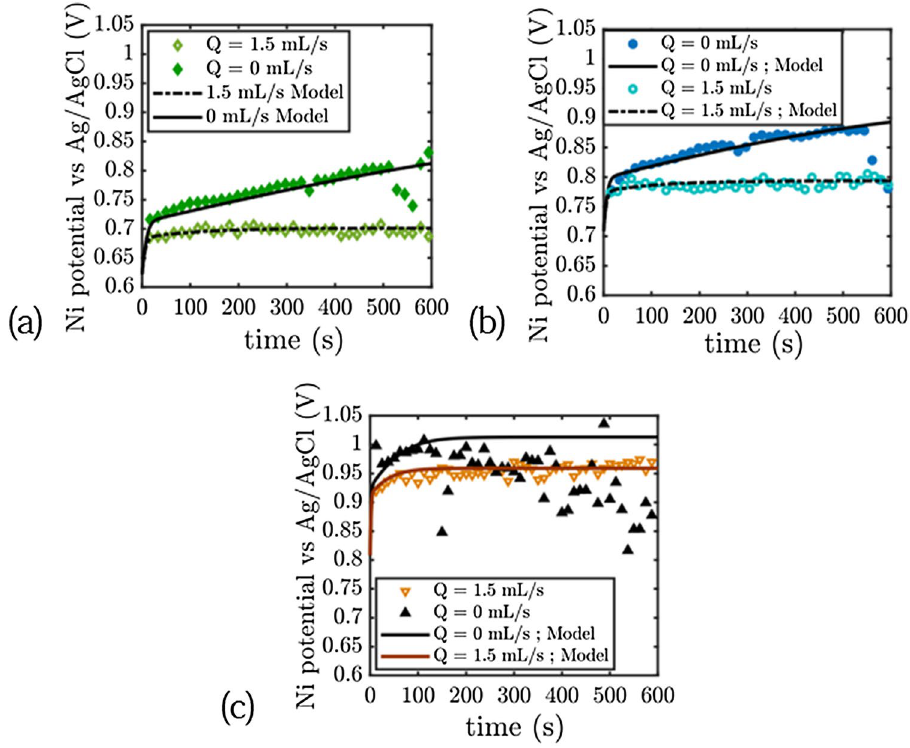
Figure 3. Chronopotentiometry of the Nickel electrode versus Ag/AgCl electrode during OER in 8M KOH/1M zincate electrolyte. ( a ) j = 3 mA/cm 2 . ( b ) j = 5 mA/cm 2 . ( c ) j = 20 mA/cm 2